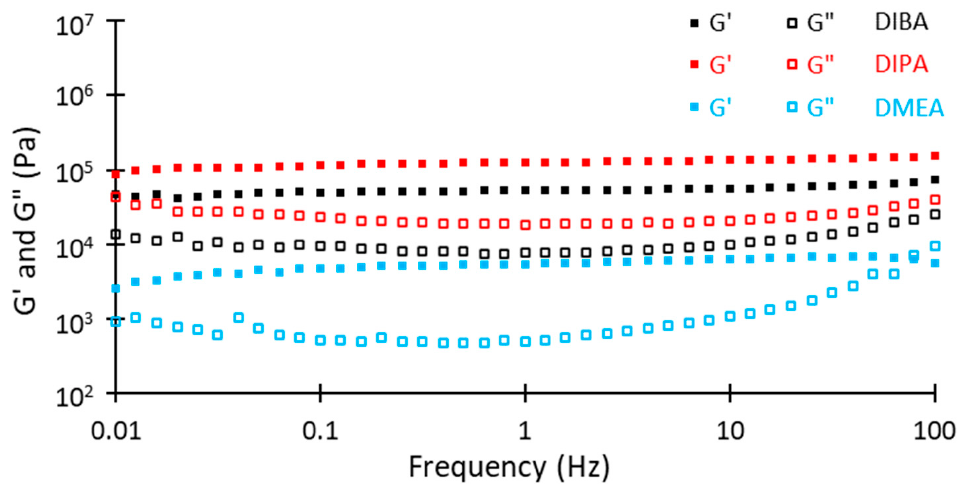
Figure 7. Log–log frequency sweeps (0.01% strain) at 25 °C: 3 wt% DIBA-silicone oil gel ( black ); 3 wt% DIPA-silicone oil gel ( red ) and 3 wt% DMEA-silicone oil gel ( blue ). 3 wt% DIPA-silicone oil gel ( red ) and 3 wt% DMEA-silicone oil gel ( blue